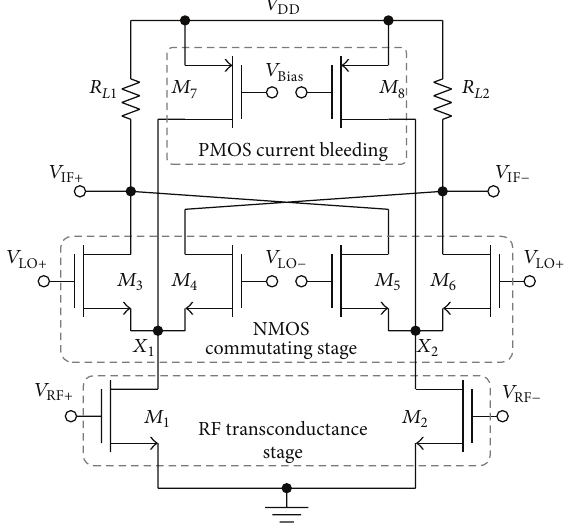
Figure 1: Conventional current bleeding mixer.